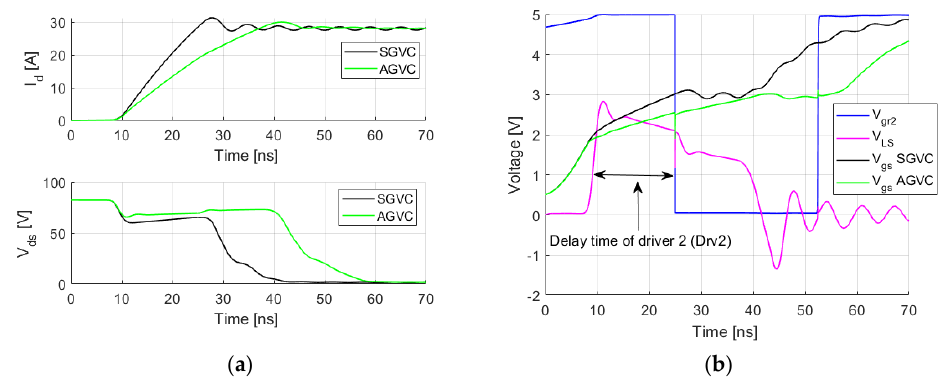
Figure 15. Simulated waveform of the main voltage and current using the proposed closed-loop active gate voltage circuit (AGVC) and standard gate voltage control (I d = 28 A, L s = 2 nH), ( a ) V ds and I d , ( b ) V Ls , V gr2 , V gs of AGVC and V gs of SGVC.